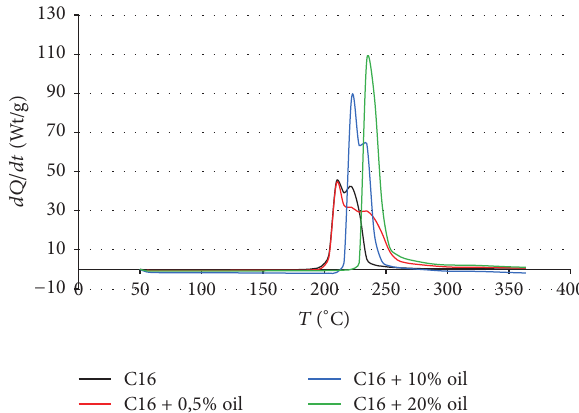
Figure 2: Heat output for hexadecane and hexadecane solutions with oil of various concentrations oxidation (inhibition effect of crude